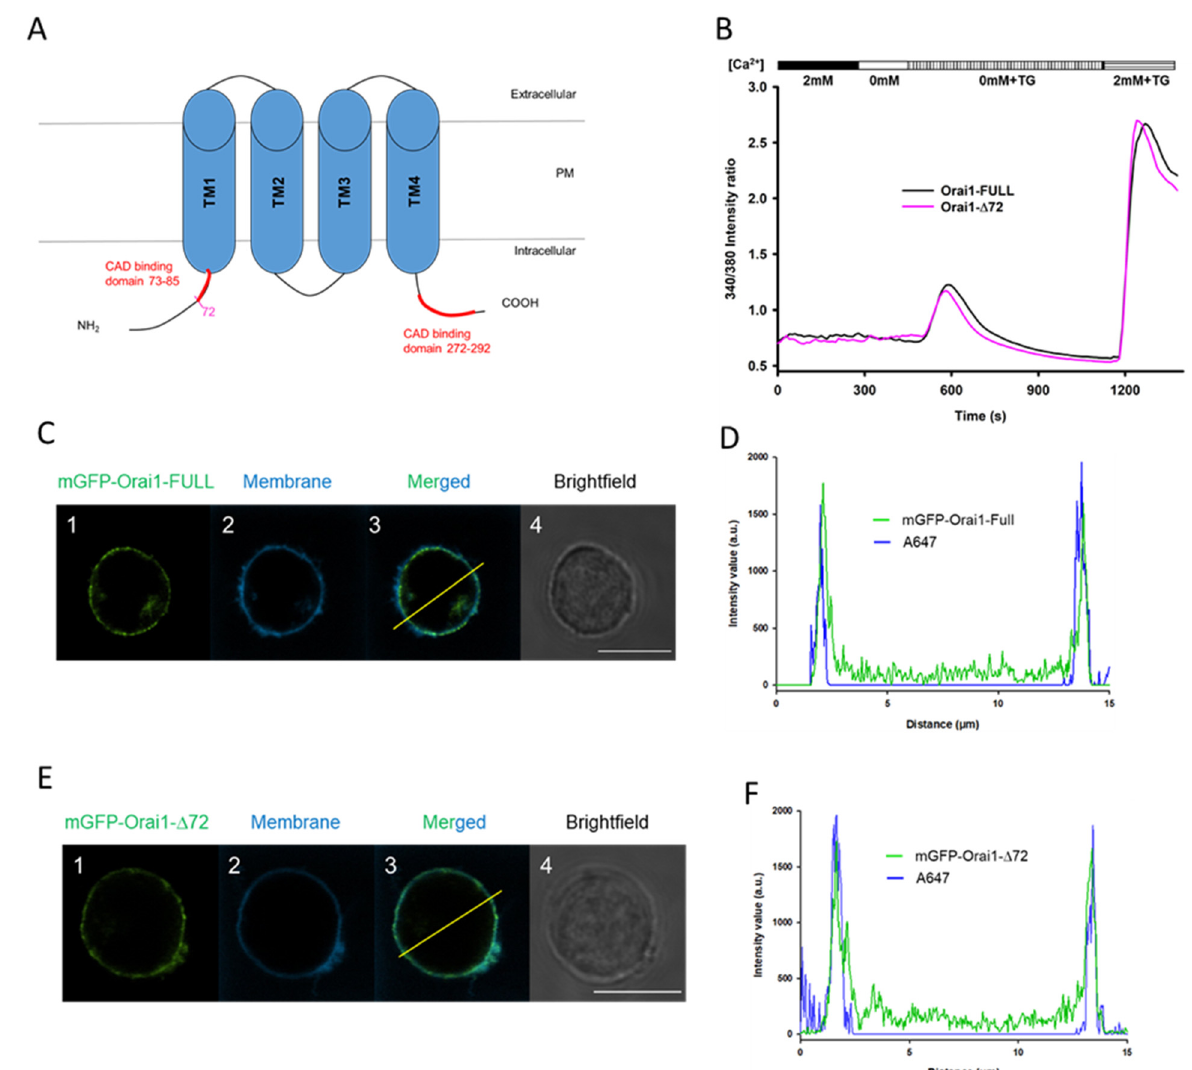
Figure 4. Removing the N terminal part of Orai1 (mGFP-Orai1- ∆ 72) does not impact the channel expression and function. ( A ) Schematic illustration of the wild type full-length (Full) Orai1 channel in the plasma membrane with intracellular C- and N-terminal tails. CRAC activation domains (CAD) are labelled with red on the N terminal (73–85 aa) and on the C terminal (272–292 aa) and 72nd amino acid for the deletion mutant of Orai1 (mGFP-Orai1- ∆ 72) is red. ( B ) Cytosolic Ca 2+ measurements in Jurkat cells stably expressing the mGFP-Orai1-Full (black) and mGFP-Orai1- ∆ 72 (pink) channels based on the 340 nm/380 nm intensity ratio. For the representative traces at least 63 cells were recorded per channel phenotype. ( C , E ) Representative confocal images of mGFP-Orai1-Full and mGFP-Orai1- ∆ 72 channels stably expressed in Jurkat cells. ( C1 , E1 ): mGFP signal of mGFP-Orai1-Full and mGFP-Orai1- ∆ 72 channels, respectively (green). ( C2 , E2 ): The Alexa Fluor™ 647 NHS Ester fluorescence of the plasma membrane (blue). ( C3 , E3 ): The merge of green and blue channels, note the overlap of signals. ( C4 , E4 ): Brightfield images of different Orai1 channels expressing cells. Scale bar is 10 µm for both image sets. The pixel-by-pixel intensity profile analysis of ( D ) mGFP-Orai1-Full and ( F ) mGFP-Orai1- ∆ 72 channels via the line indicated in the merged image ( C3 , E3 ): green: mGFP-Orai1; blue: membrane, Alexa-647 NHS ester.